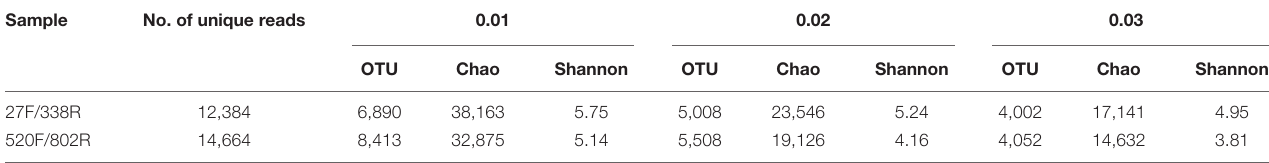
TABLE 3 | Measures of alpha-diversity of samples characterized for three OTU definitions a . Sample